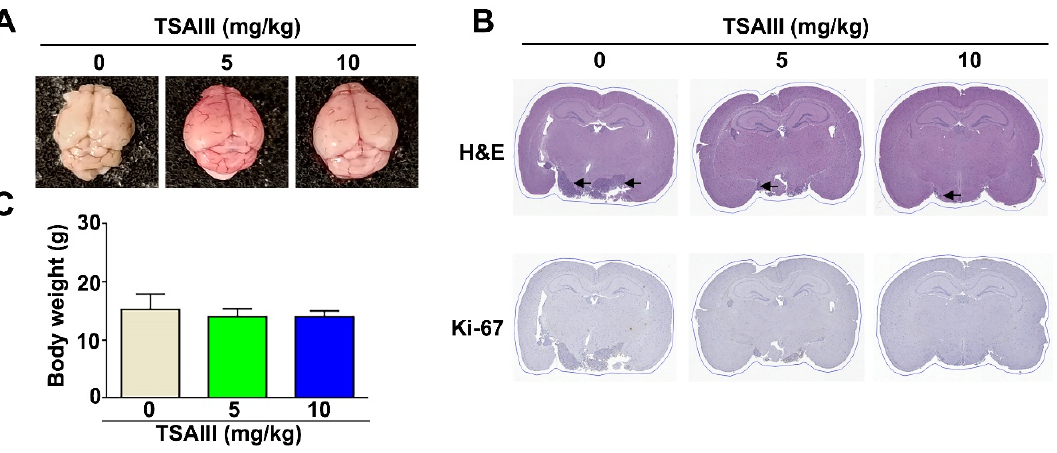
Figure 7. Tumor growth inhibition in orthotopic GBM8401 nude mice by TSAIII. ( A ) Orthotopic glioma tumor formation in the brain of nude mouse. ( B ) H&E staining was determined with histol- ogy, and the ki-67 expression was detected with an immunohistochemistry assay in orthotopic gli- oma tumors. ( C ) Body weight was measured one time per week until 21 days. The position of tumor formation is arrowed.